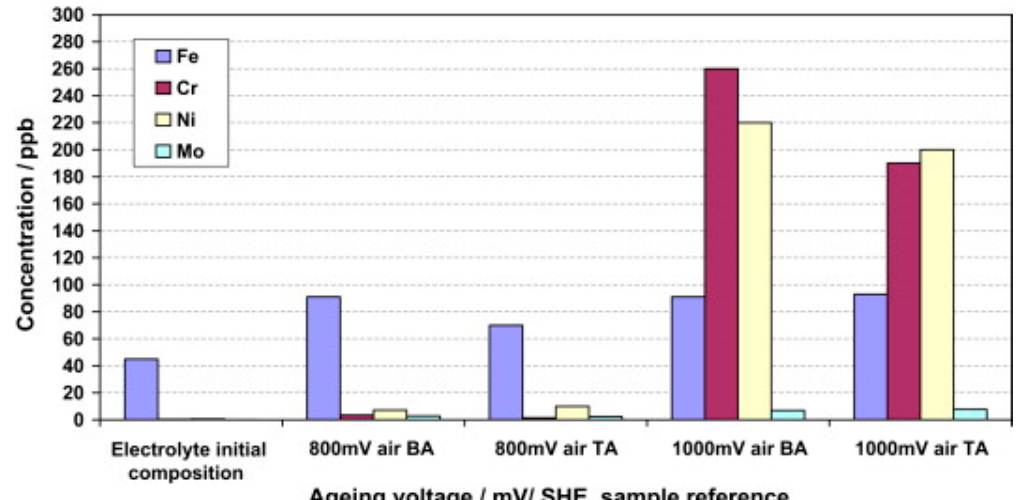
Figure 17. The amount of ions released after 500 h of exposure of AISI 316L depending on the applied potential (BA = bright annealing state). Reprinted from [16] copyright (2015), with permission from Elsevier.